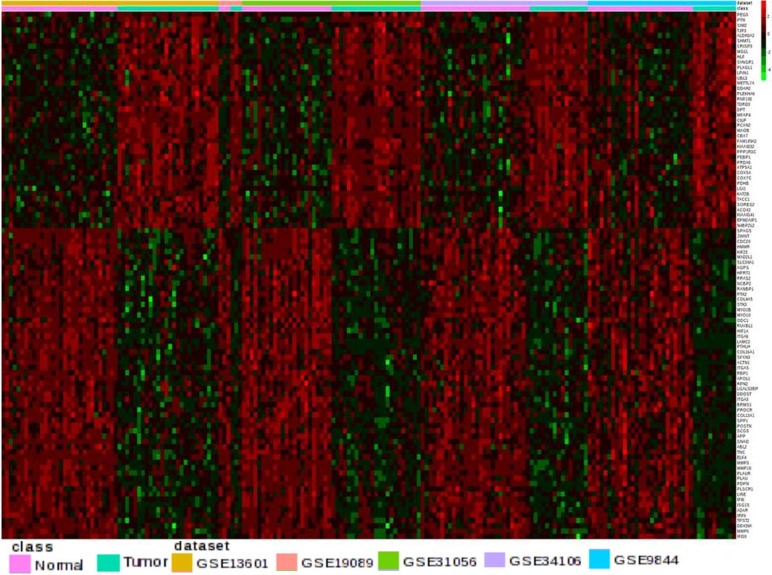
Heat map showing DEG.The up regulated (red) and down regulated genes (green) shown after meta-analysis. The top bar shows the GEO dataset ID and the second bar shows the classification of tumor vs. normal. The gene list is shown in the right.